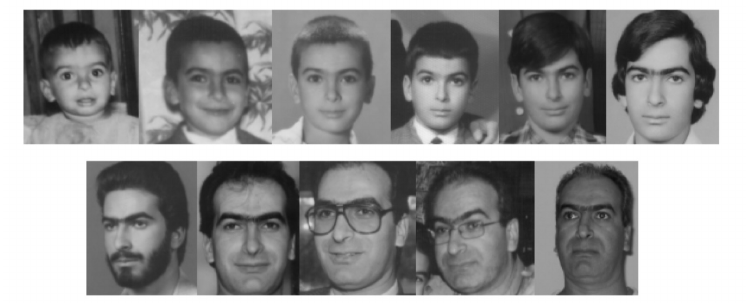
Figure 2. Changes in facial appearance from childhood to